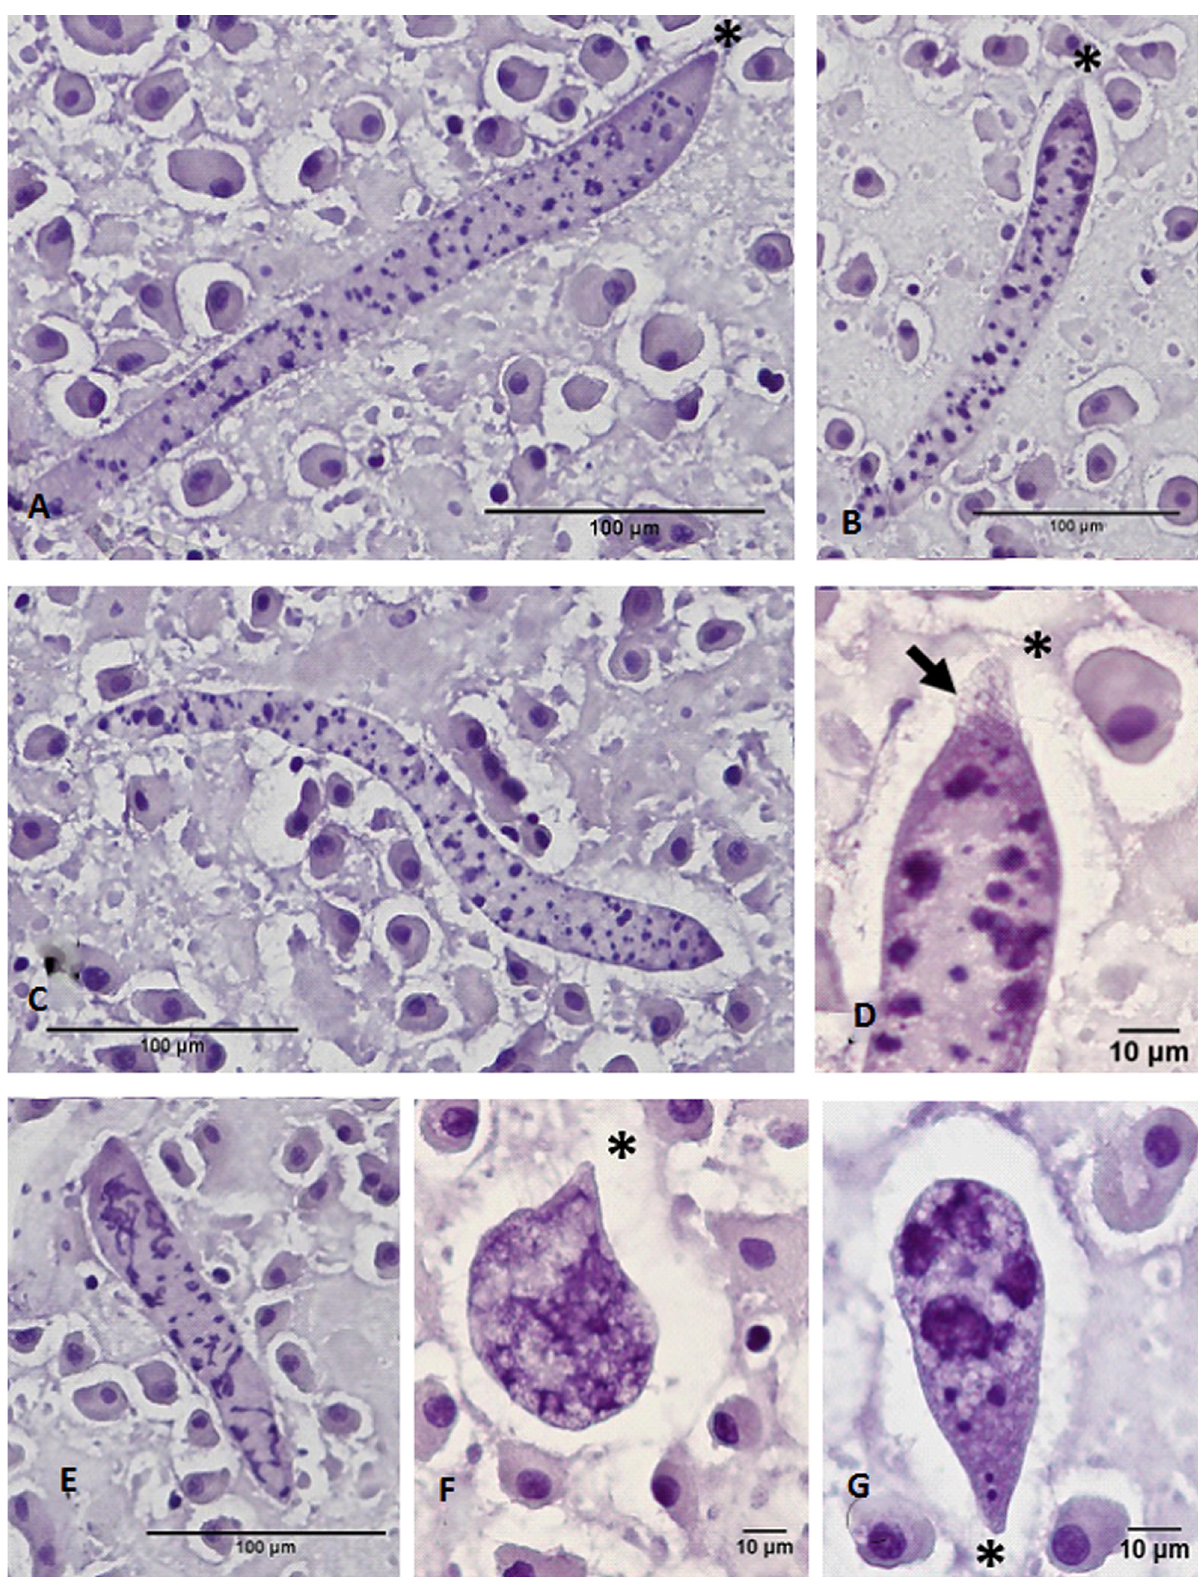
Figure 3. Chromidina sp . S50: morphology. (A–C, E) Tropho-tomonts: anterior end has a conical shape terminated by an apical papillum. (D) Enlargement of Figure 3B showing the apical papillum and the ciliature consisting of spiralled kineties originating from at the apex (arrow). (F, G) Degenerative-like or cyst-like forms. *: apical